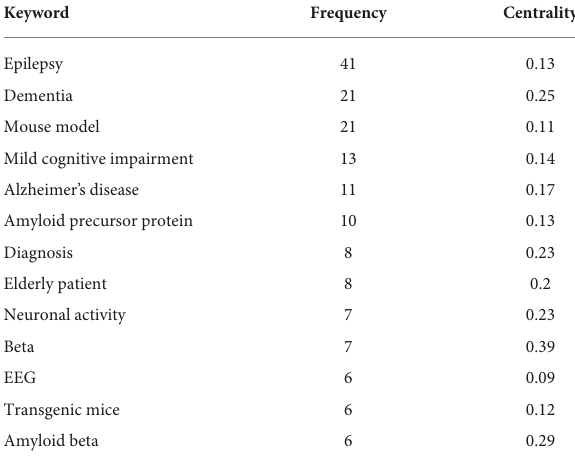
TABLE 6 Frequency of co-occurring